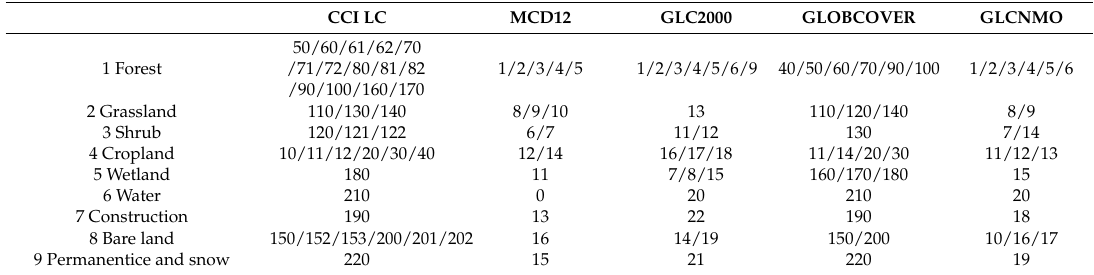
Table 2. Classification schemes that were employed for the five global land-cover